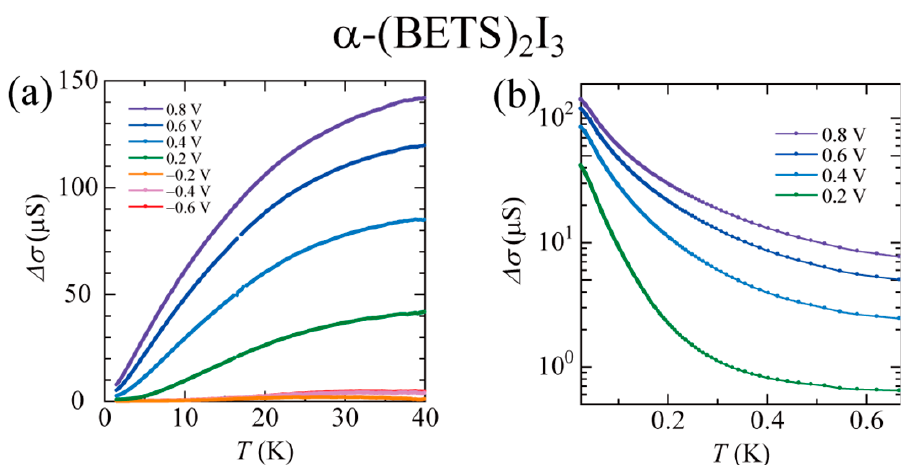
Figure 6. ( a ) Temperature dependence of the gate-induced conductivity in α -(BETS) 2 I 3 . ( b ) Arrhenius plots of the gate-induced conductivity.